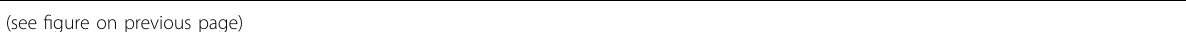
Fig. 3 The de fi ciency of DA-DRD5 signaling inhibits M1 but enhances M2 macrophage polarization in vitro. A RT-qPCR analysis of Inos and Tnf mRNA expression in WT BMDMs treated with various doses of DA and stimulated with LPS/IFN- γ (M1) for 12 h. B ELISA analysis of TNF- α in supernatants from WT BMDMs treated with various doses of DA and stimulated with LPS/IFN- γ (M1) for 12 h. C Flow cytometry analysis of M1 marker CD86 of WT BMDMs treated with DA (20 μ M) and stimulated with LPS/IFN- γ (M1) for 12 h. Representative overlaid fl ow cytometry histograms showing mean fl uorescence intensity (MFI) (top) and quanti fi ed data from three independent experiments ( n = 3 per group) (bottom). D Immunoblot analysis of Inos in lysates of WT BMDMs treated with DA (20 μ M) and stimulated with LPS/IFN- γ (M1) for 12 h. E RT-qPCR analysis of Inos and Tnf mRNA expression in WT and DRD5 − / − BMDMs treated with DA (20 μ M) and stimulated with LPS/IFN- γ (M1) for 12 h. F ELISA analysis of TNF- α in supernatants from WT and DRD5 − / − BMDMs treated with DA (20 μ M) and stimulated with LPS/IFN- γ (M1) for 12 h. G Flow cytometry analysis of M1 marker CD86 of WT and DRD5 − / − BMDMs treated with DA (20 μ M) and stimulated with LPS/IFN- γ (M1) for 12 h. Representative overlaid fl ow cytometry histograms showing mean fl uorescence intensity (MFI) (left) and quanti fi ed data from three independent experiments ( n = 3 per group) (right). H Immunoblot analysis of Inos in lysates of WT and DRD5 − / − BMDMs treated with DA (20 μ M) and stimulated with LPS/IFN- γ (M1) for 12 h. I RT-qPCR analysis of Arg1 and Mrc1 mRNA expression in WT BMDMs treated with various doses of DA and stimulated with IL-4/IL-13 (M2) for 12 h. J Flow cytometry analysis of M2 marker CD206 of WT BMDMs treated with DA (20 μ M) and stimulated with IL-4/IL-13 (M2) for 12 h. Representative overlaid fl ow cytometry histograms showing mean fl uorescence intensity (MFI) (left) and quanti fi ed data from three independent experiments ( n = 3 per group) (right). K Immunoblot analysis of Arg1 in lysates of WT BMDMs treated with DA (20 μ M) and stimulated with M2 for 12 h. L RT-qPCR analysis of Arg1 and Mrc1 mRNA expression in WT and DRD5 − / − BMDMs treated with DA (20 μ M) and stimulated with IL-4/IL-13 (M2) for 12 h. M Flow cytometry analysis of M2 marker CD206 of WT and DRD5 − / − BMDMs treated with DA (20 μ M) and stimulated with IL-4/IL-13 (M2) for 12 h. Representative overlaid fl ow cytometry histograms showing mean fl uorescence intensity (MFI) (left) and quanti fi ed data from three independent experiments ( n = 3 per group) (right). N Immunoblot analysis of Arg1 in lysates of WT and DRD5 − / − BMDMs treated with DA (20 μ M) and stimulated with IL-4/IL-13 (M2) for 12 h. Data are pooled from three independent experiments. Error bars show means ± SEM. * p < 0.05, ** p < 0.01, *** p < 0.001; NS, not signi fi cant. One-way ANOVA with Sidak ’ s multiple comparisons test for ( A – C, E – G, I – J, L – M